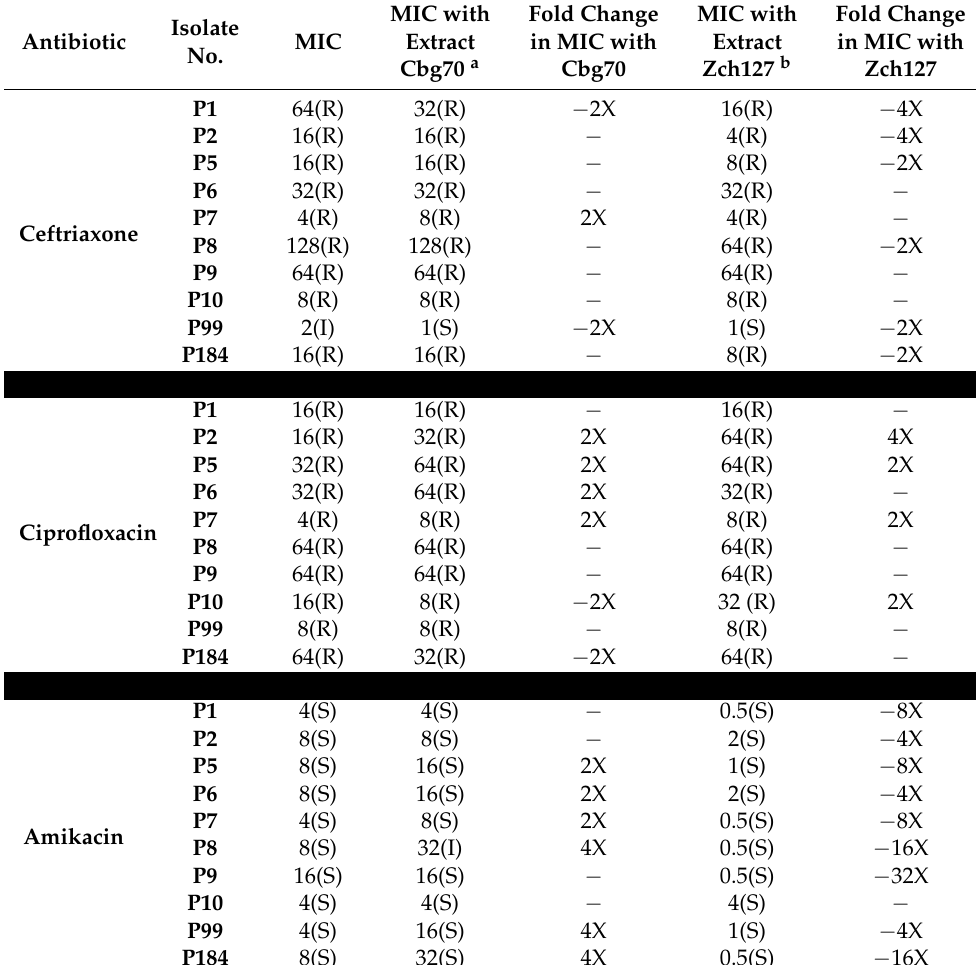
Table 1. Fold changes in minimum inhibitory concentration of selected antibiotics in presence of indole derivatives crude extracts at sub-MIC against Proteus mirabilis